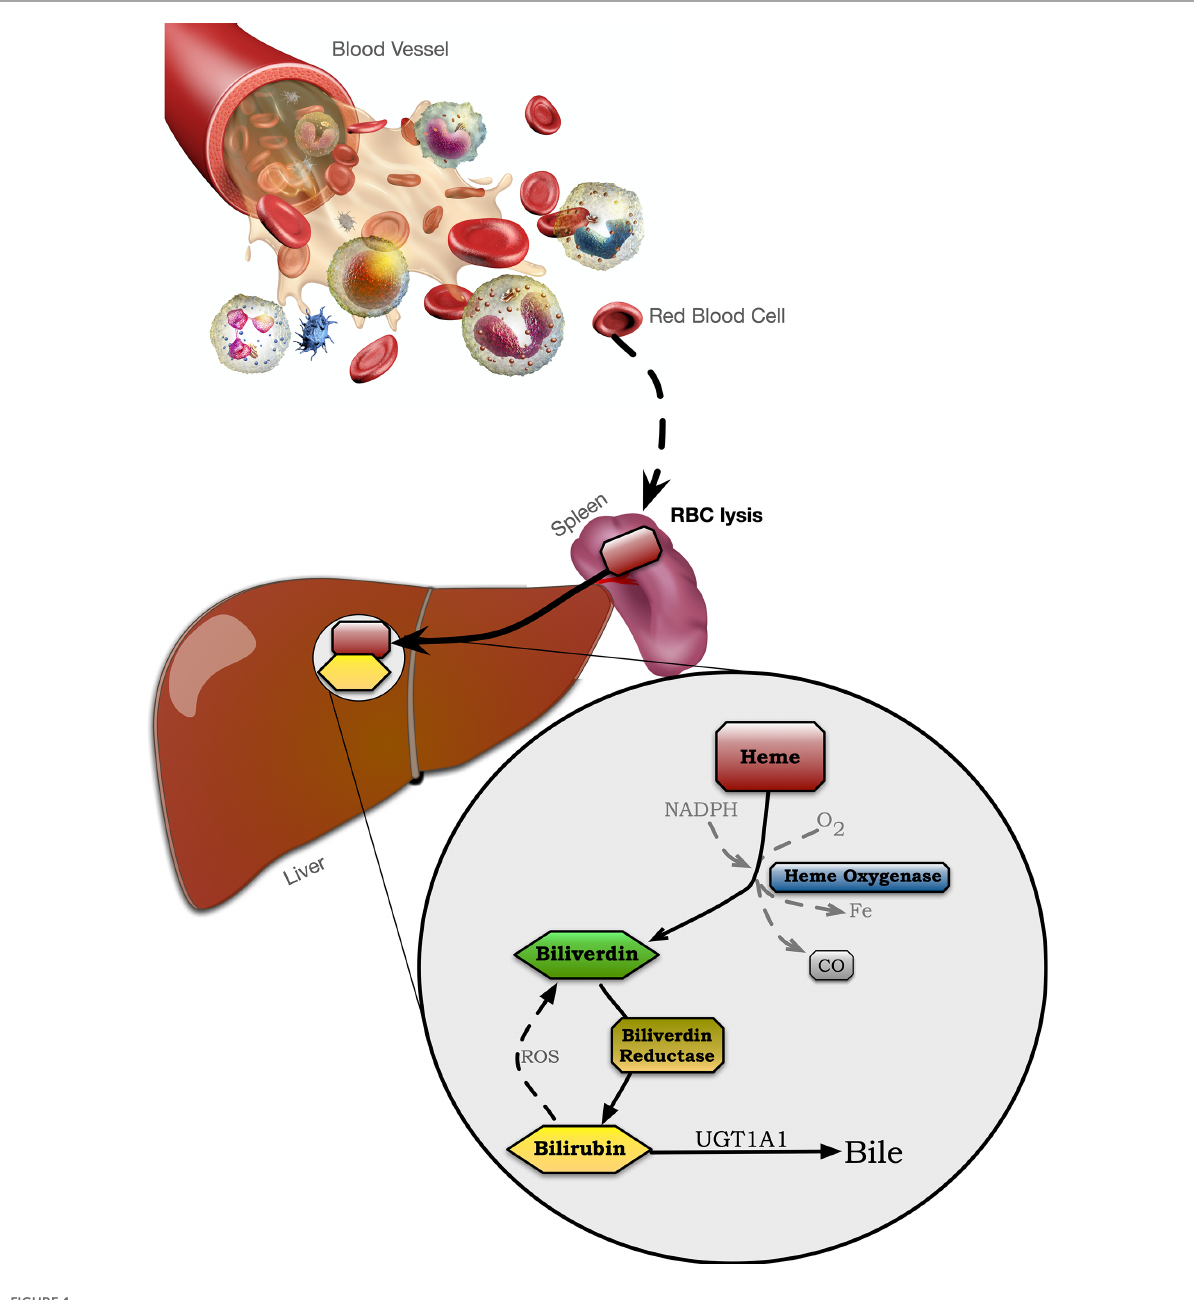
FIGURE 1 The heme oxygenase-bilirubin